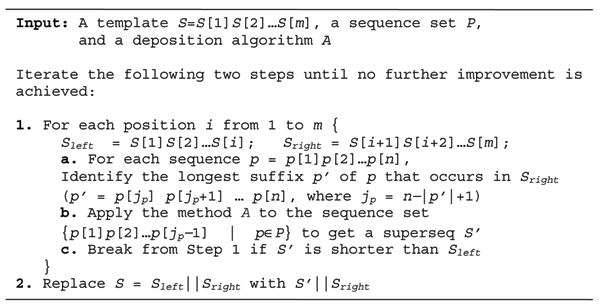
The procedure of the reduction process.